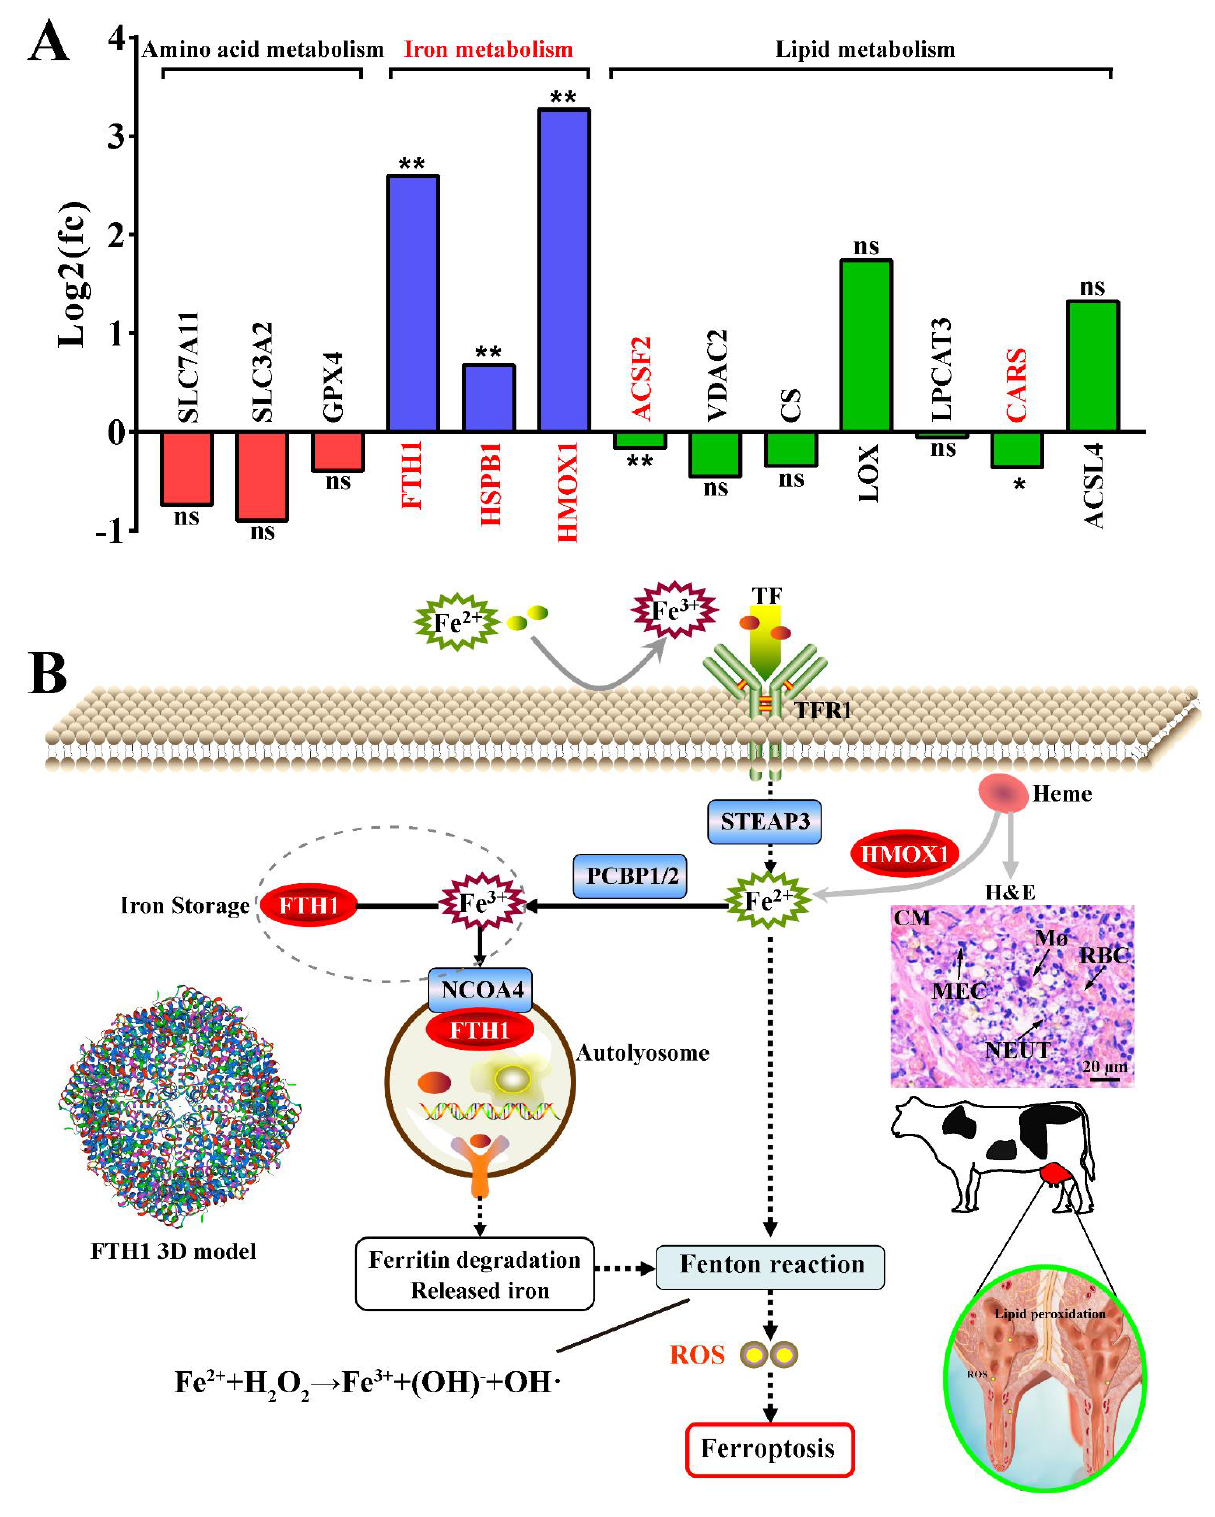
Figure 7. The deduced mechanism of HMOX1 promoting ferroptosis via FTH1 in the mammary glands of Holstein cows with CM. ( A ) The selected proteins associated with ferroptosis based on DIA proteomics. ( B ) The mechanism of ferroptosis in the mammary glands of Holstein cows with CM. MECs, Mammary epithelial cells. RBC, red blood cells. NEUT, neutrophil. M, macrophages. FC, fold change. CM, clinical mastitis. Scale bar of 20 µ m represents 630 × . Statistical analyses: Wilcoxon rank sum test, α = 0.05. Data are presented as median (rank). * represents p < 0.05, ** represents p < 0.01 and ns represents no